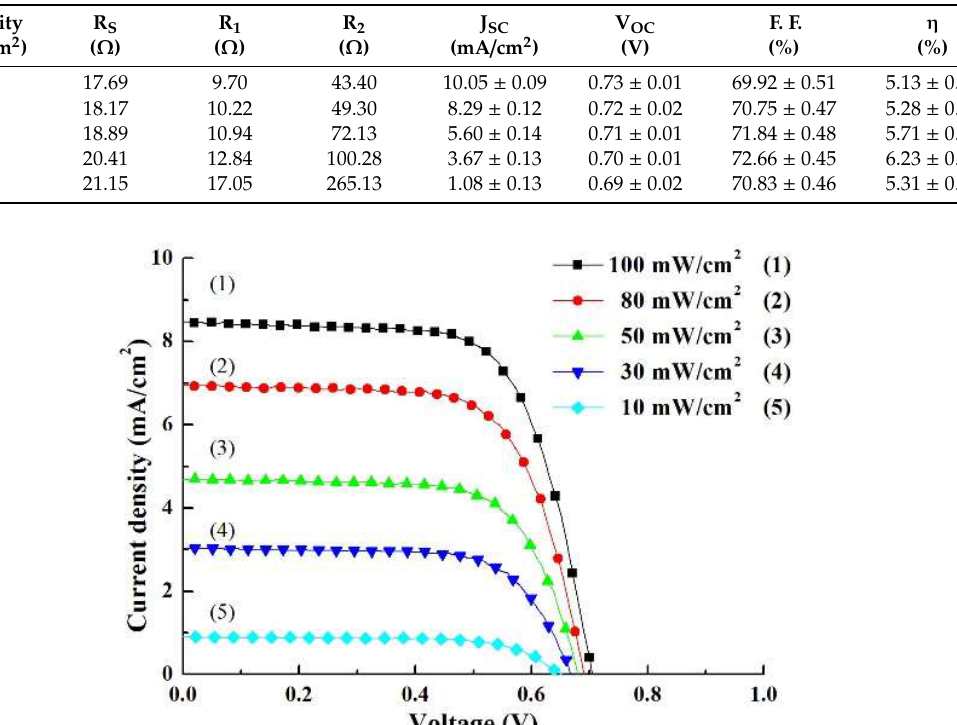
Table 4. Parameters of DSSC based on TANLP.